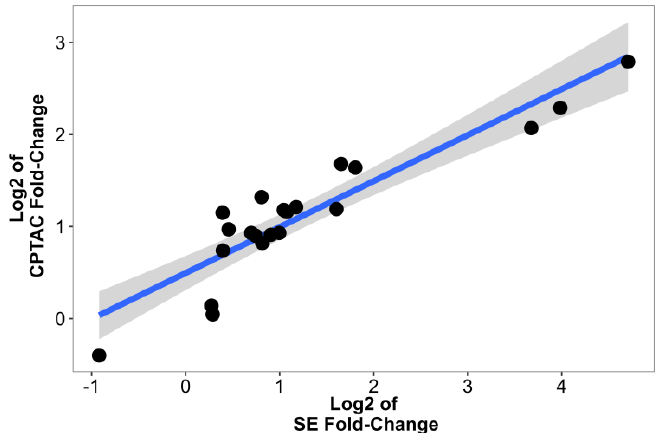
Figure 6. Correlation analysis of log-transformed CPTAC and SE Fold-change values. Each dot represents a FC value of a protein, we also added a trend line using a linear model. Table 3. Summary table of own MS data and CPTAC protein expression differences.